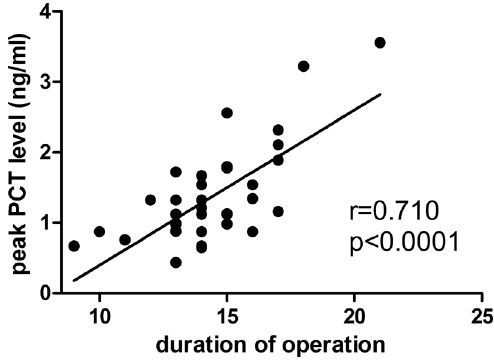
Figure 3 - Relationship between peak level of PCT and dura- tion of operation. Based on the Pearson correlation. PCT: procalcitonin.